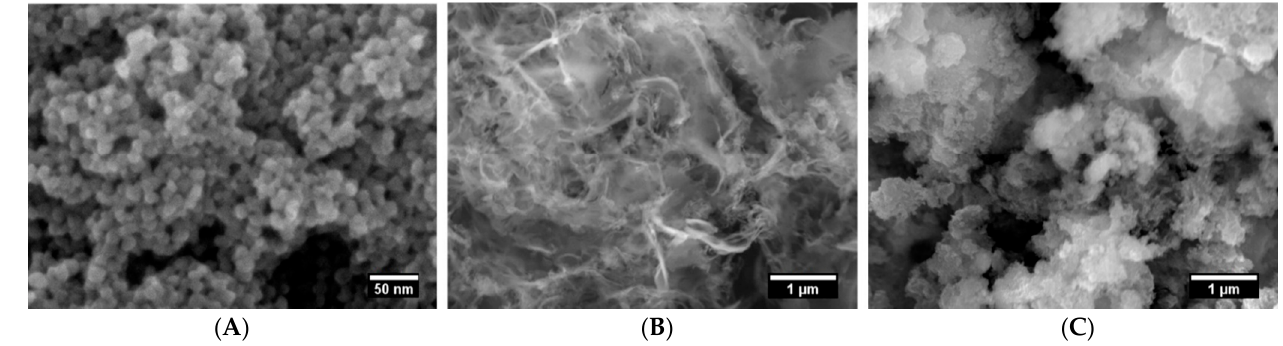
Figure 4. SEM images of prepared ( A ) pure TiO 2 nanoparticles, ( B ) g -C 3 N 4 , and ( C ) 32% g -C 3 N 4 @TiO 2 nanocomposite.